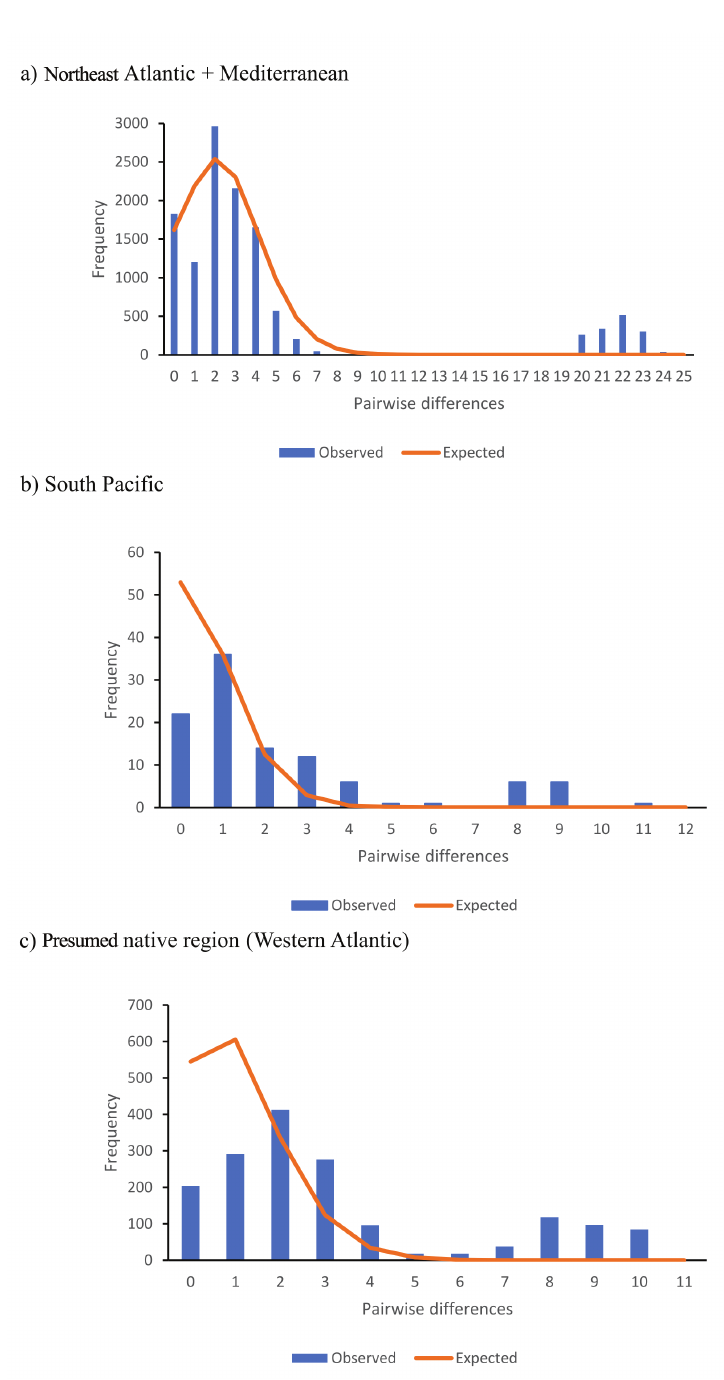
Figure 4. Mismatch distribution of Paracaprella pusilla for each region. a) Europe (Northeast Atlantic + Mediterranean), b) Australia (South Pacific), and c) presumed native region. Blue bars show the observed frequency distributions and the orange lines represent the expected ones under the sudden expansion